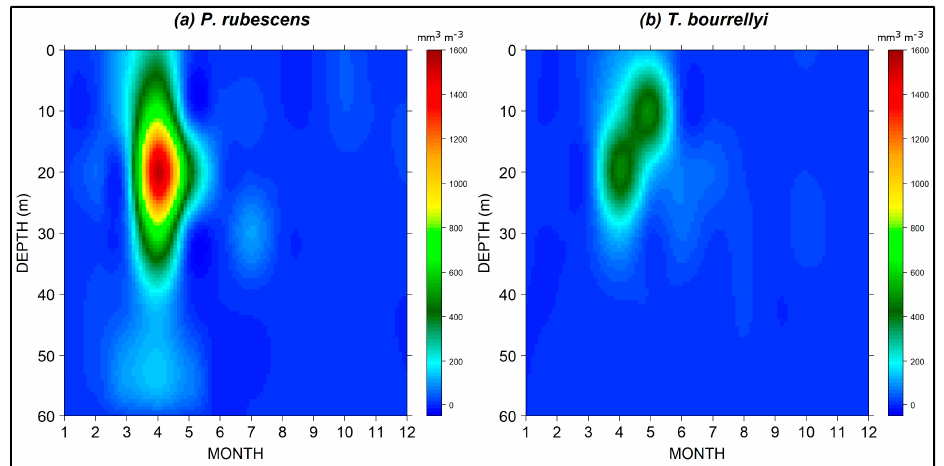
Figure 5. Contour plots showing the spatial and temporal distribution in Lake Iseo during 2016 of ( a ) P. rubescens biovolume (mm 3 /m 3 ); ( b ) T. bourrellyi biovolume (mm 3 /m 3